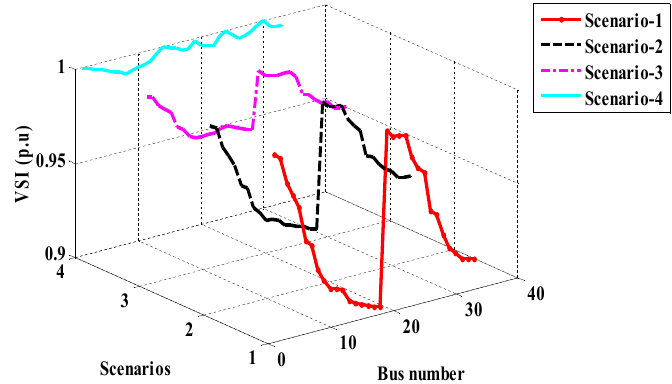
Figure 5. Comparison of active power loss for various scenarios (IEEE 33-Bus).